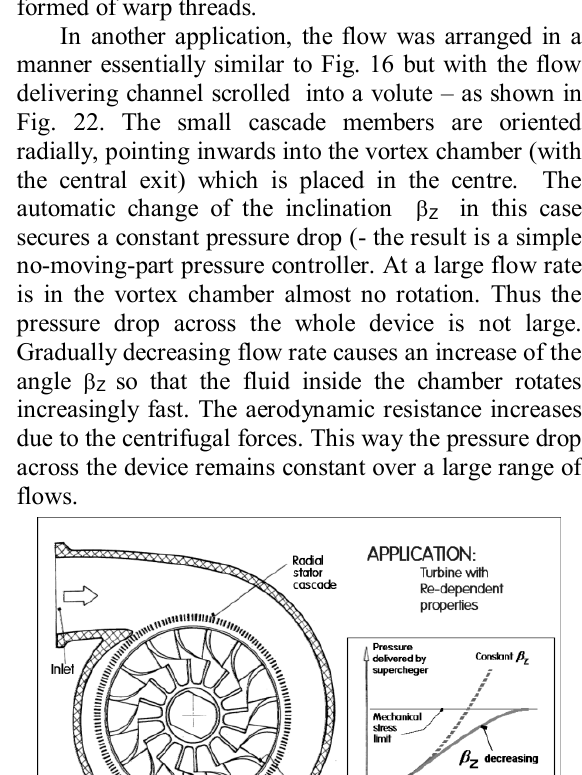
Fig. 21. Typical photograph of the measurements of the refraction angle  Z . This is the case that finally demonstrated the existence of the vortices B . On the other hand, it revealed also the presence of vortices C and D (Fig. 20) at the trailing edges of the blades.